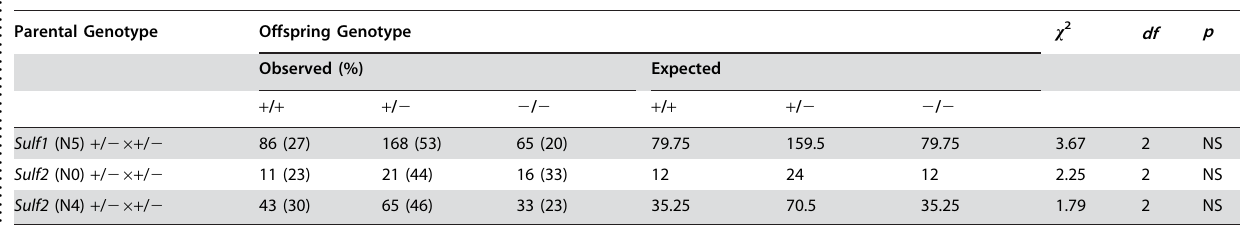
Table 1. Sulf1 2 / 2 and Sulf2 2 / 2 mice are present at Mendelian frequencies. .. ... .... ... ... .... ... ... .... ... ... .... ... ... .... ... ... .... ... ... .... ... ... .... ... ... .... ... ... .... ... ... .... ... ... .... ... ... .... ... ... .... ... ... . Parental